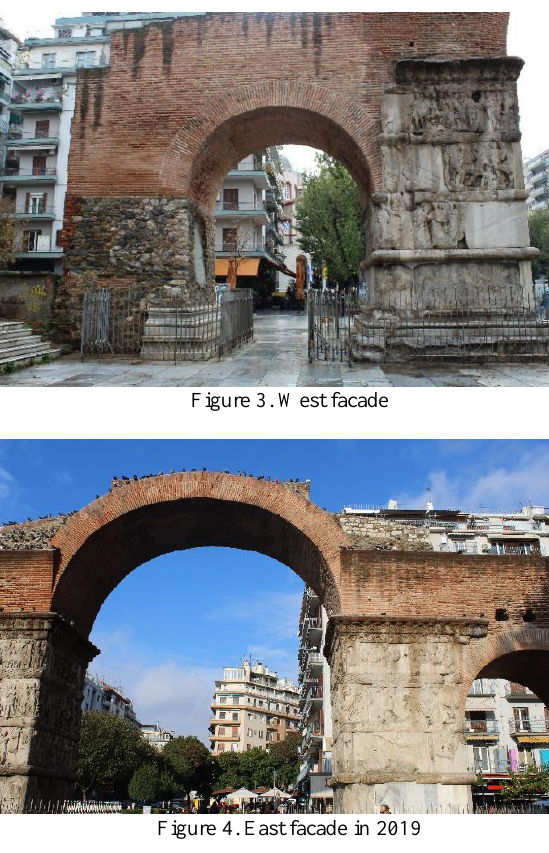
Figure 4. East facade in 2019